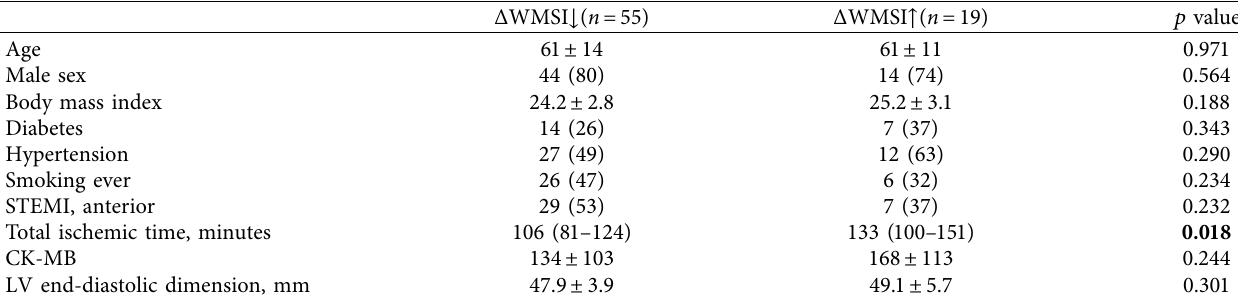
Values are presented as mean ± standard deviation, n (%), or median (interquartile range). CK-MB, creatine kinase-MB fraction; LV, left ventricle; STEMI, ST-segment elevation myocardial infarction. Statistical significance was defined as p < 0 . 05 by Welch’s t -test (continuous variables) or the chi-squared test (categorical variables). The values in bold indicate statistical significance ( p < 0 . 05).